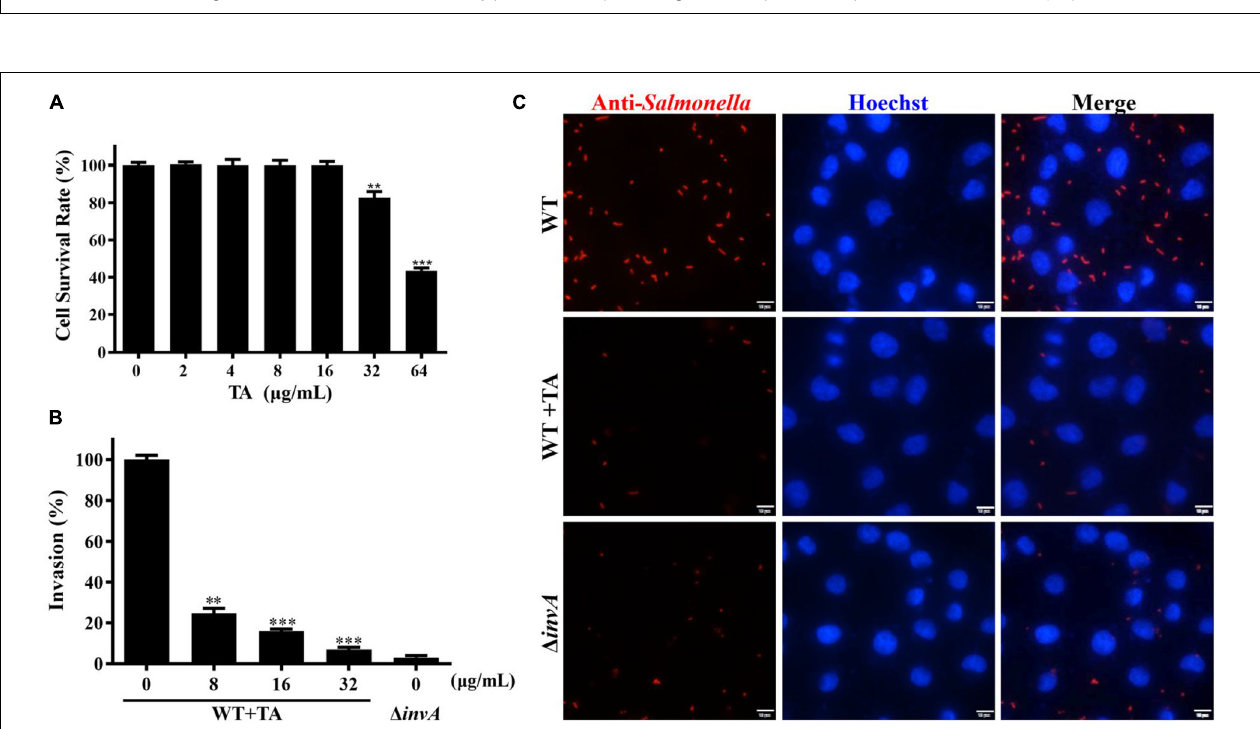
FIGURE 1 | Tannic acid protects mice from S. Typhimurium infection. (A) The chemical structure of TA. (B) TA improved the survival rate of S. Typhimurium infected mice ( n = 10). (C) Autopsy analysis of S . Typhimurium infected mice. (D) Histopathological observations of S . Typhimurium infected mice by HE staining. (E) The bacterial load in several organs of infected mice on the fifth day post-infection (NS, no significance; * p < 0.05; ** p < 0.01, Scale bar, 100 µ m).